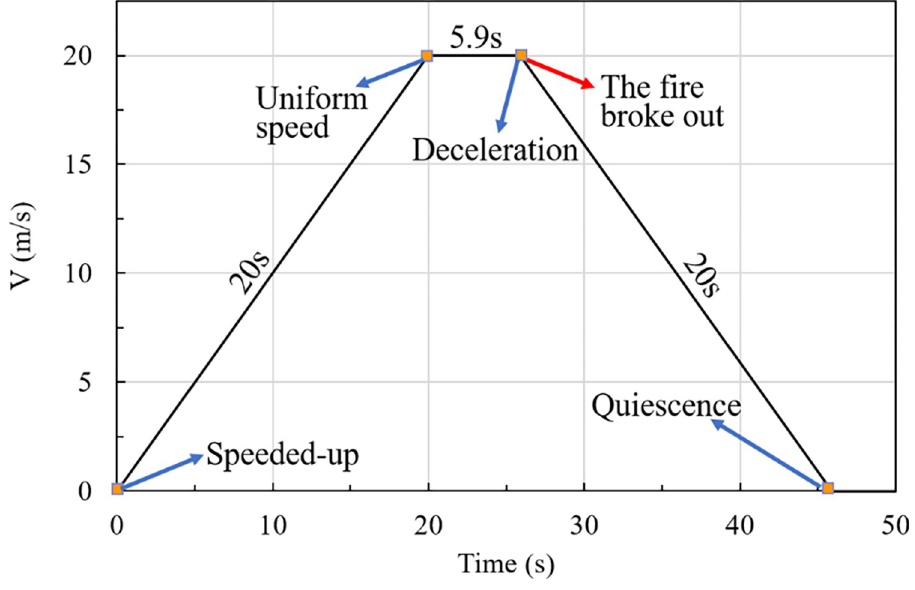
Fig 9. Curve of train